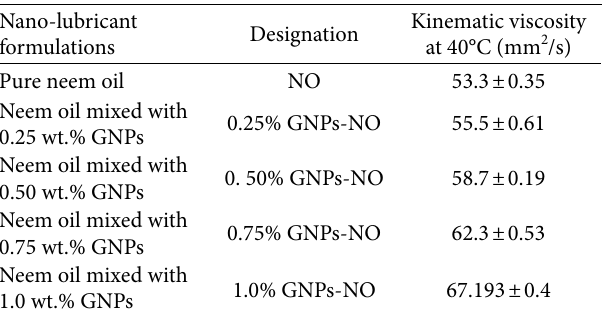
Table 1: Kinematic viscosity of various wt.% of GNPs-neem nano-lubricants.